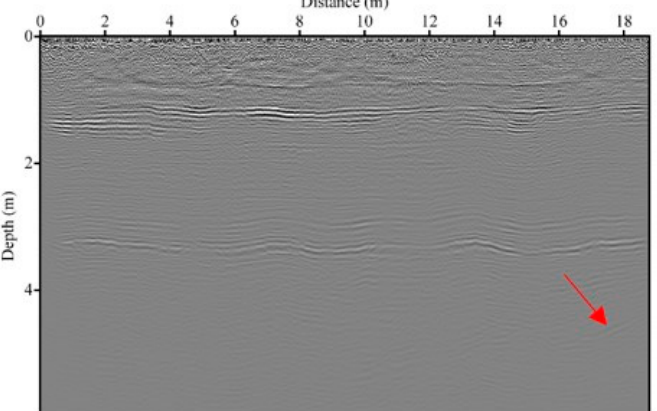
Figure 15. PP imaging based on VDWE.